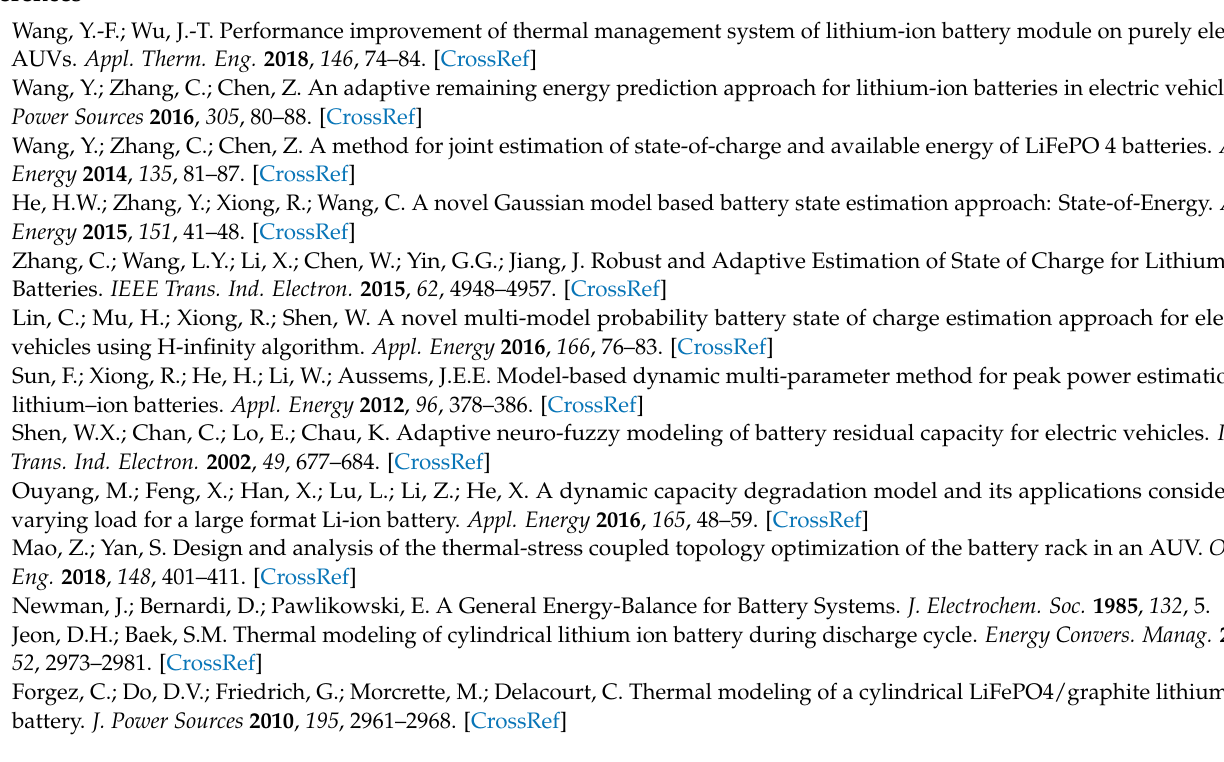
the output voltages of the battery under 1C discharging U 2 the output voltages of the battery under 2C discharging the current value corresponding to 1C discharging. U mean the average open circuit voltage of the battery during